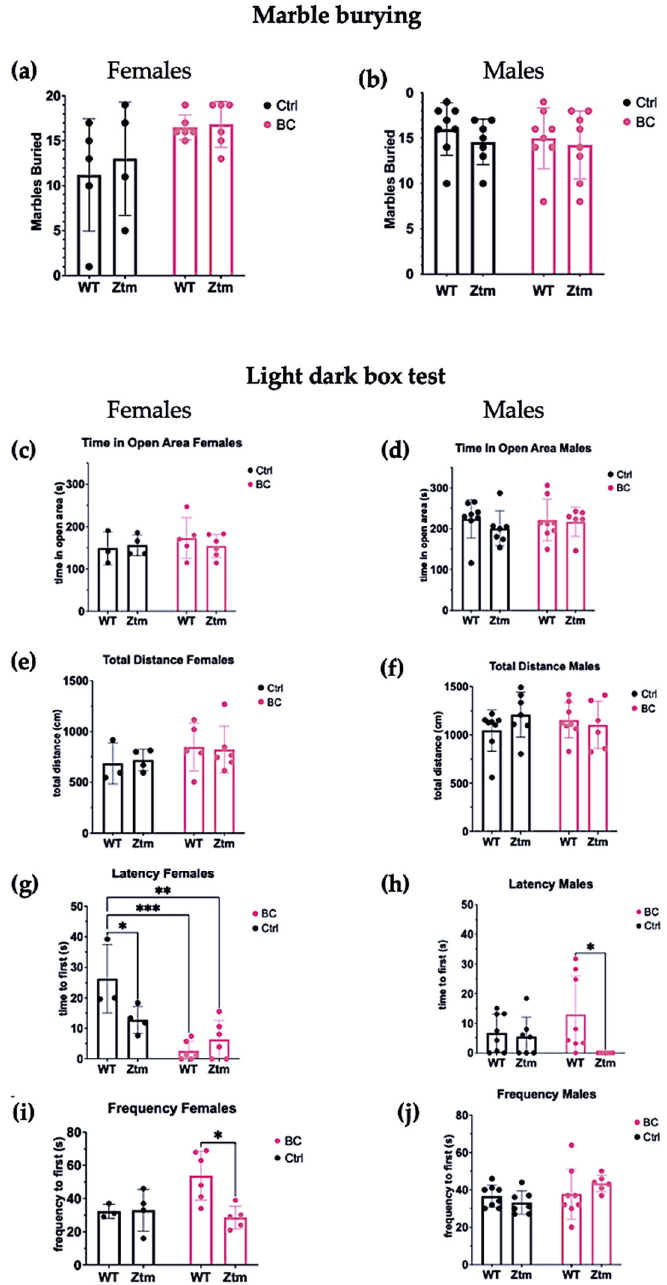
Figure 8. A behavior profile of WT and Ztm mice measuring treatment effects post BC application. Marble burying ( a , b ): No significant difference was observed in total number of marbles buried between the groups. Light dark box ( c – j ): No significant difference was observed for time spent in open area between any of the groups ( c , d ). No significant difference was observed in total distance traveled between the groups ( e , f ).Within the female groups, latency to enter the light section was significantly different between WT BC and WT control groups ( p = 0.0003), and between Ztm BC and WT control groups ( p = 0.001) ( g ). A significant difference was observed in latency to enter the light section between WT male BC and Ztm male BC groups ( p = 0.03) ( h ). There was a significant difference in frequency of transitions between WT female BC and Ztm BC groups ( p = 0.01) ( i ). No significant difference was observed in frequency of transitions between any of the WT or Ztm male groups ( j ). n = 53. WT = wild-type mice; BC = bovine colostrum treatment; Ctrl = control mice; Ztm = zonulin transgenic mice; n = total number of mice. * p < 0.05; ** p < 0.005; *** p < 0.0005; p values adjusted with Tukey´s HSD.